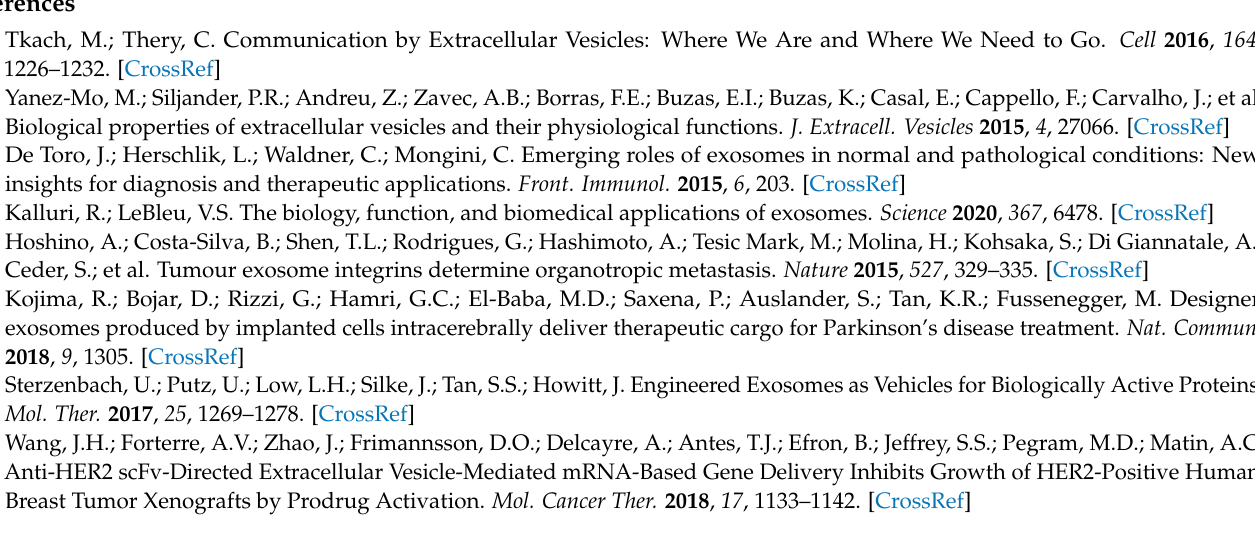
Table S3: Proteins overlapping in WT, DNAJB6WT, and DNAJB6-M3 EVs; Table S4: Proteins differ- entially expressed in comparisons between WT and DNAJB6-WT EVs, WT and DNAJB6-M3 EVs, DNAJB6-WT and DNAJB6-M3